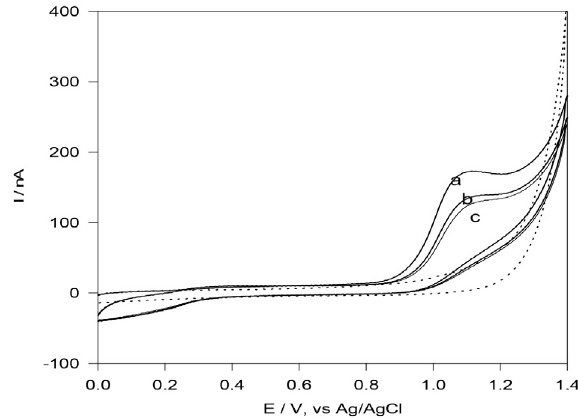
Figure 1 . Successive cyclic voltammograms for 3.85 × 10 –5 mol/L solution of chlorzoxazone in 0.04 mol/L Britton-Robinson buffer pH 6.5 and scan rate of 50 mV/s on carbon paste electrode. Voltam- mograms: a, first cycle; b, second cycle; c, third cycle, and the dotted voltammogram represents the blank.